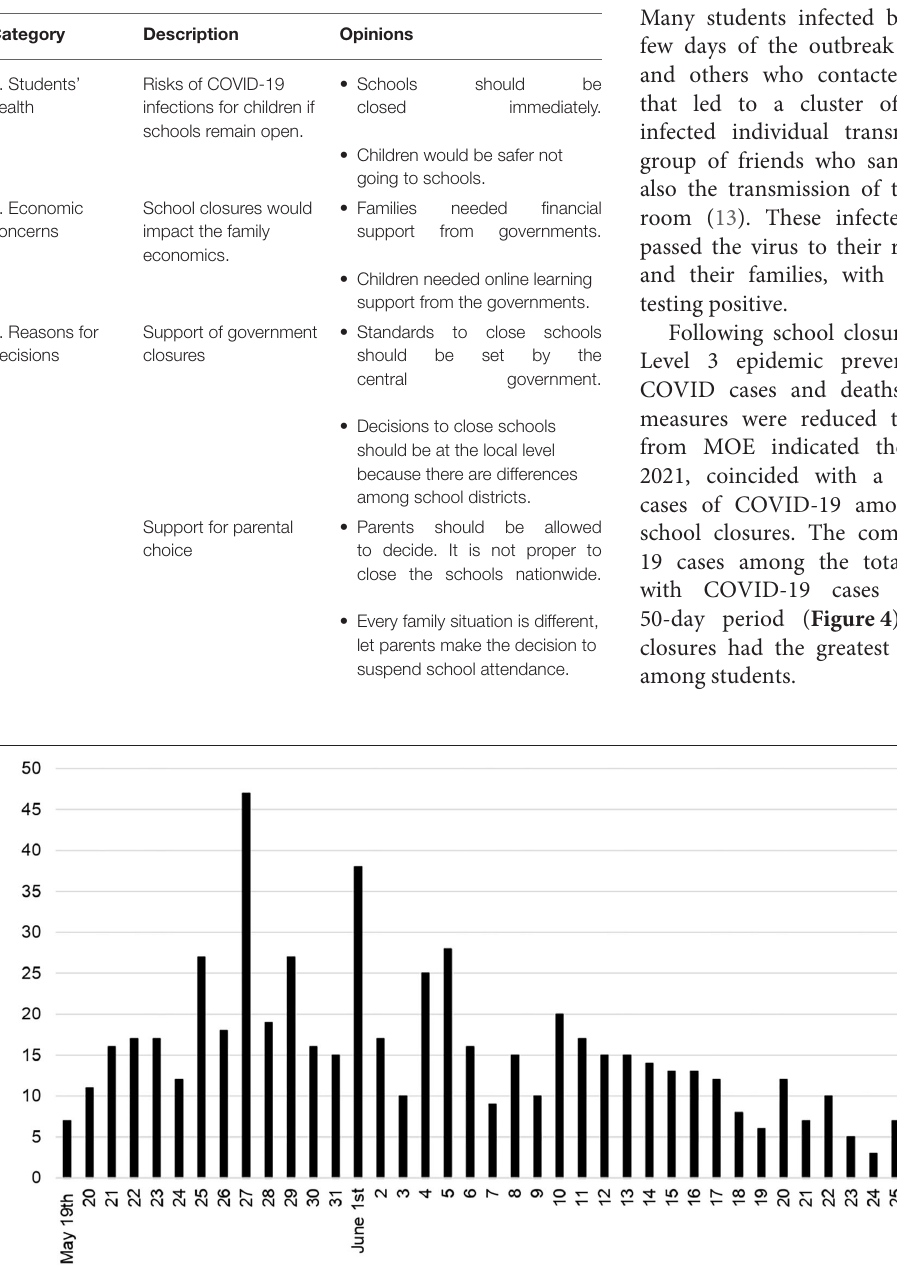
FIGURE 4 | Number of new daily cases of COVID-19 among students in Taiwan following closures of all schools in Taiwan (Ministry of Education).